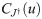
(A) Mean network correlations for synaptic equilibria under normal activity C(u) (thick green line) and under spike-triggered stimulation C†(u) (dashed red line). Mean correlations for normal network activity with synaptic equilibrium obtained from stimulation (CJ†(u)) is shown in dashed blue. External correlations C^(u) also shown (thin black line). (B) Evolution of synaptic weight averages J¯αβ(t) over time, computed with analytical estimates, color-coded as in C. External rates as in Fig 1B. Initiated at equilibrium (see Methods), spike triggered stimulation (†) is switched “on” for the indicated period. Inset shows evolutions of 10 randomly chosen synapses from group a to group b, from corresponding spiking network simulation. (C) Top: plots of mean equilibrium matrices J¯* in normal activity and under spike-triggered stimulation (left/right resp.). Bottom: snapshot of full simulated matrix J(t) once equilibria are reached (N = 60). (D) Plot of relative synaptic changes between equilibria: (J¯αβ†-J¯αβ)/Jmax with α, β ∈ {a, b, c}.